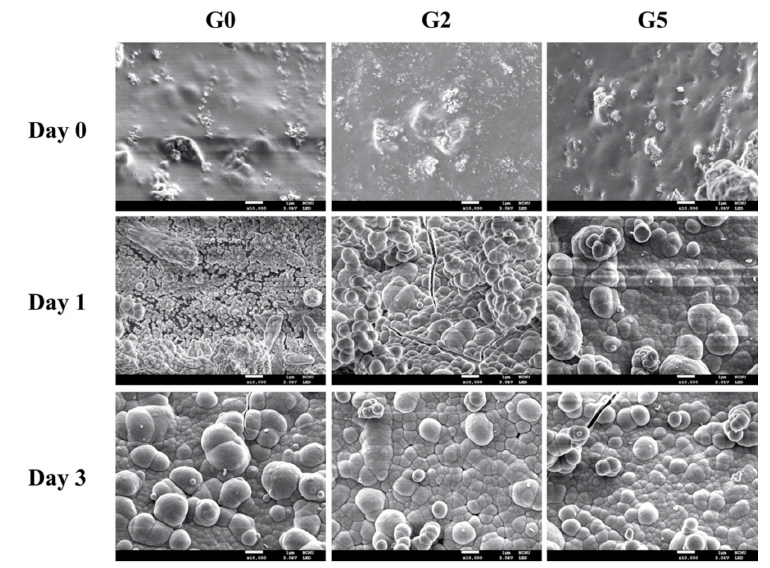
Figure 4. Surface microstructure of the G0, G2, and G5 scaffolds before and after immersion in SBF for 1 and 3 days. The scale bar is 1 µ m.